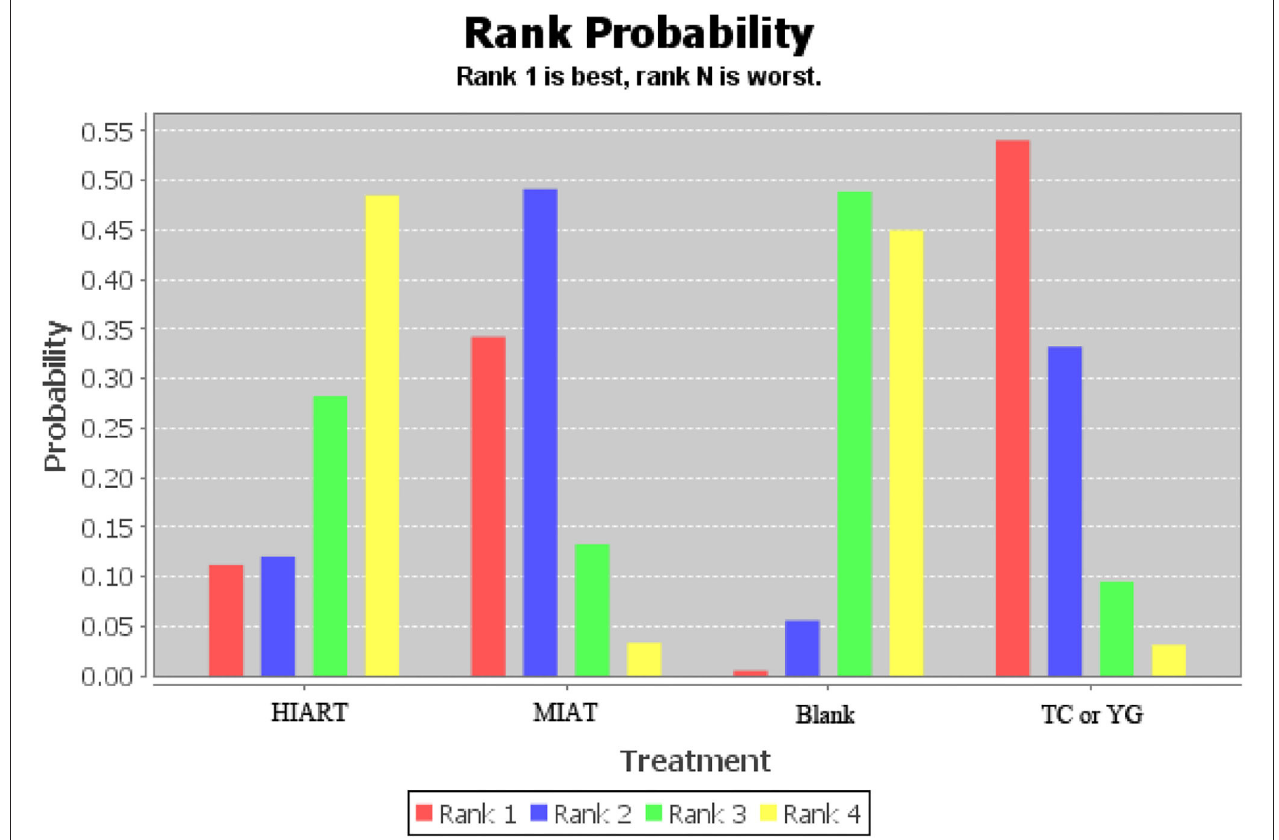
FIGURE 6 | Measurement of superoxide dismutase (SOD) and ranking of intervention probability. Blank, Blank control; HIART, High intensity aerobic mixed resistance training; MIAT, Medium intensity aerobic training; TC or YG, Tai Chi or Yoga.